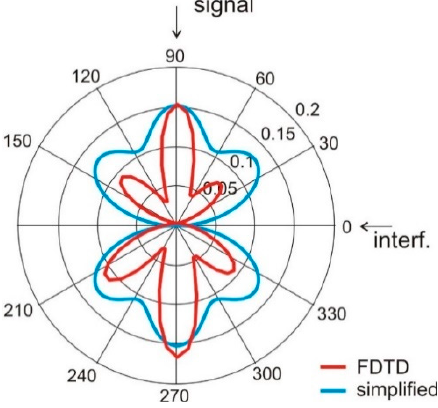
Figure 6. Antenna array radiation pattern G ( ϕ ) with four elements located on the ψ a : [ − 20 ◦ , 20 ◦ , 160 ◦ , 200 ◦ ], phasing vector α = [0,0,0,0].